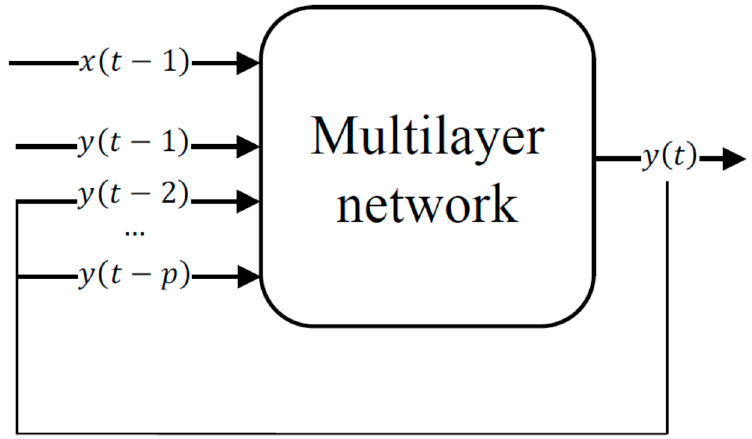
Figure 2. Non-linear autoregressive with exogenous (External) inputs Figure 2. Non ‐ linear autoregressive with exogenous (External) inputs (NARX).